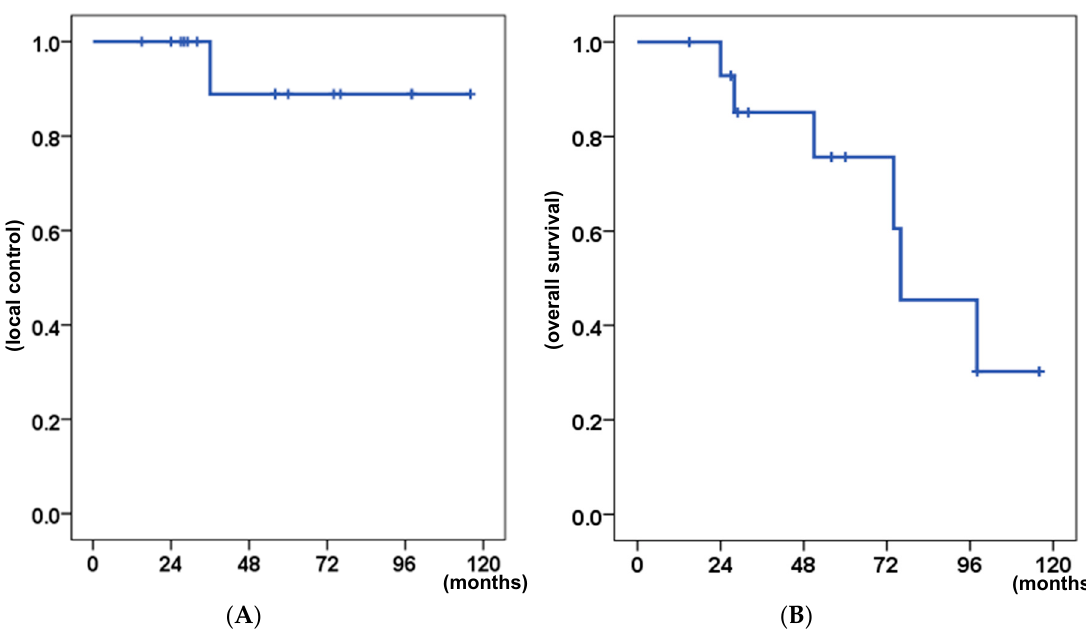
Figure 2. Kaplan–Meier curves of the clinical results for all patients. ( A ) Local control. ( B ) Overall survival.